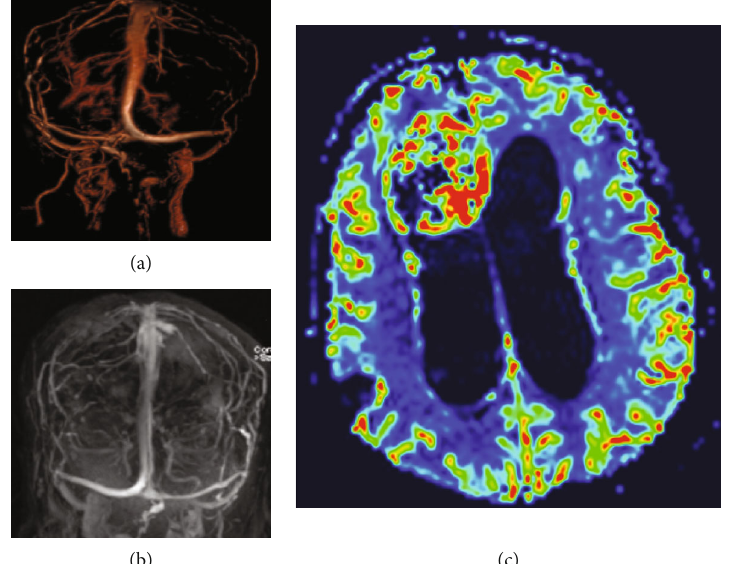
Figure 3: MRV of the cerebrum that shows patent super fi cial and deep venous system (a, b). MR perfusion shows the high perfusion hinting towards a high-grade nature of the mass (c).